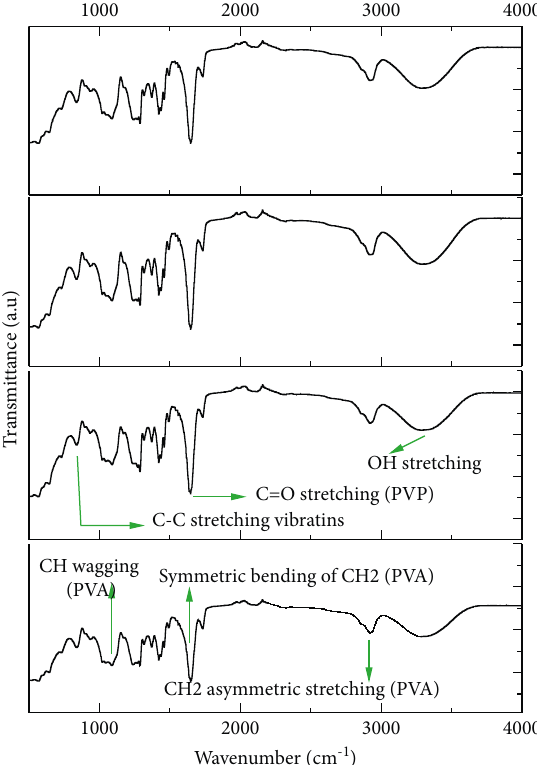
Figure 1: FTIR pattern for 50% PVA: 50% PVP with (a) 0%, (b) 0.5%, (c) 2%, and (d) 3% wt.% FeCl 2